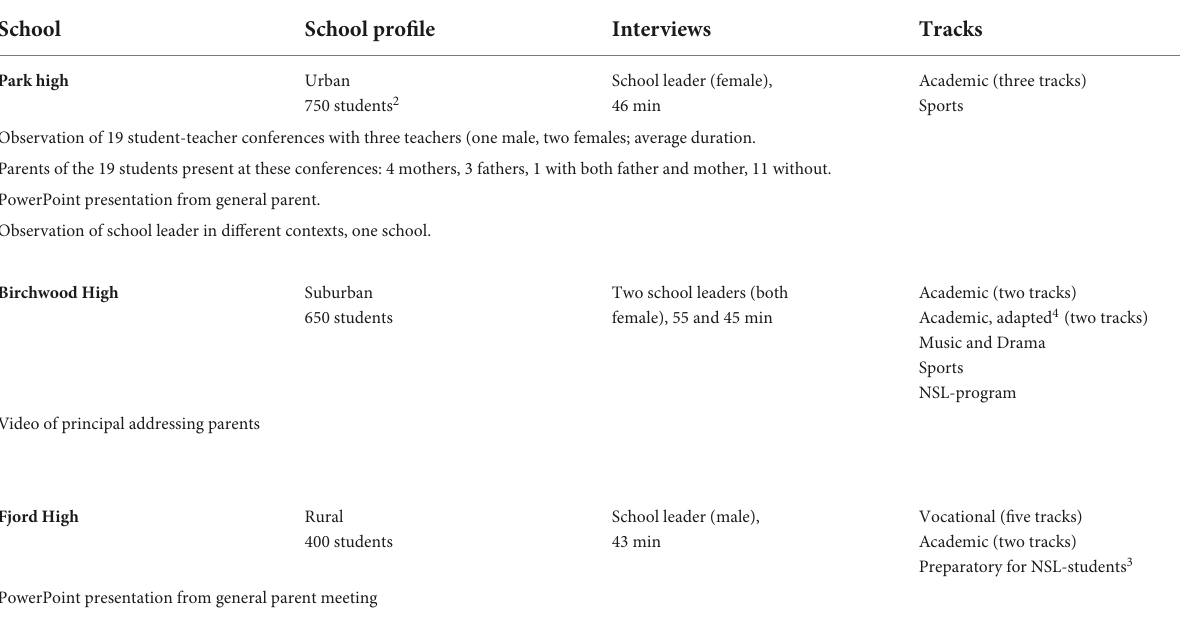
TABLE 1 School profiles and